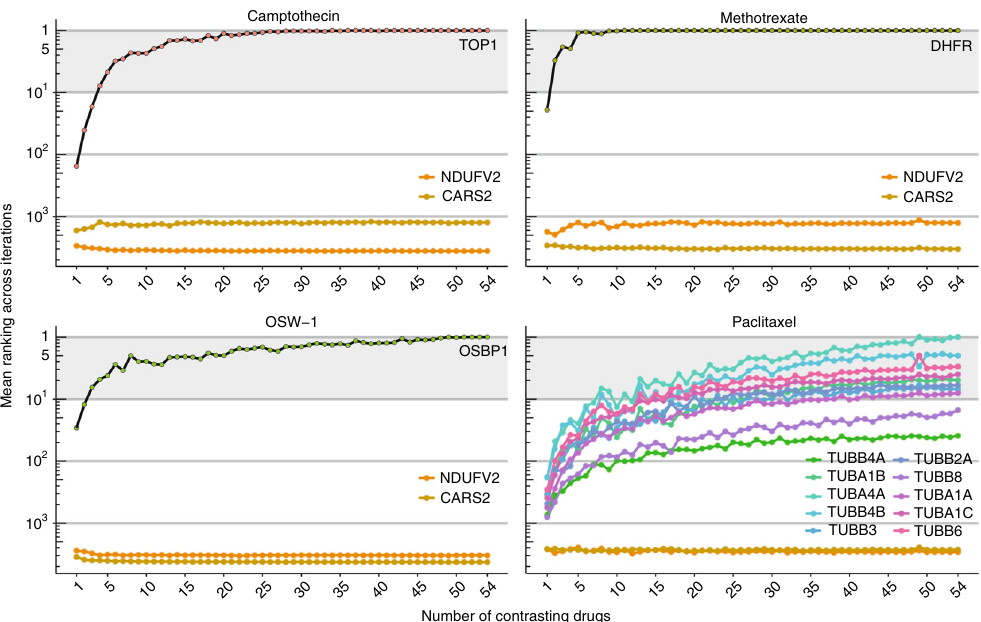
Fig. 5 Determination of the ProTargetMiner minimal size. Four compounds were contrasted against 50 random combinations of 1 – 54 compounds by PLS-DA modeling and the mean drug target ranking was calculated for each number. NDUFV2 and CARS2 proteins were randomly chosen as non-target proteins. Supplementary Data 1 was used for production of this fi